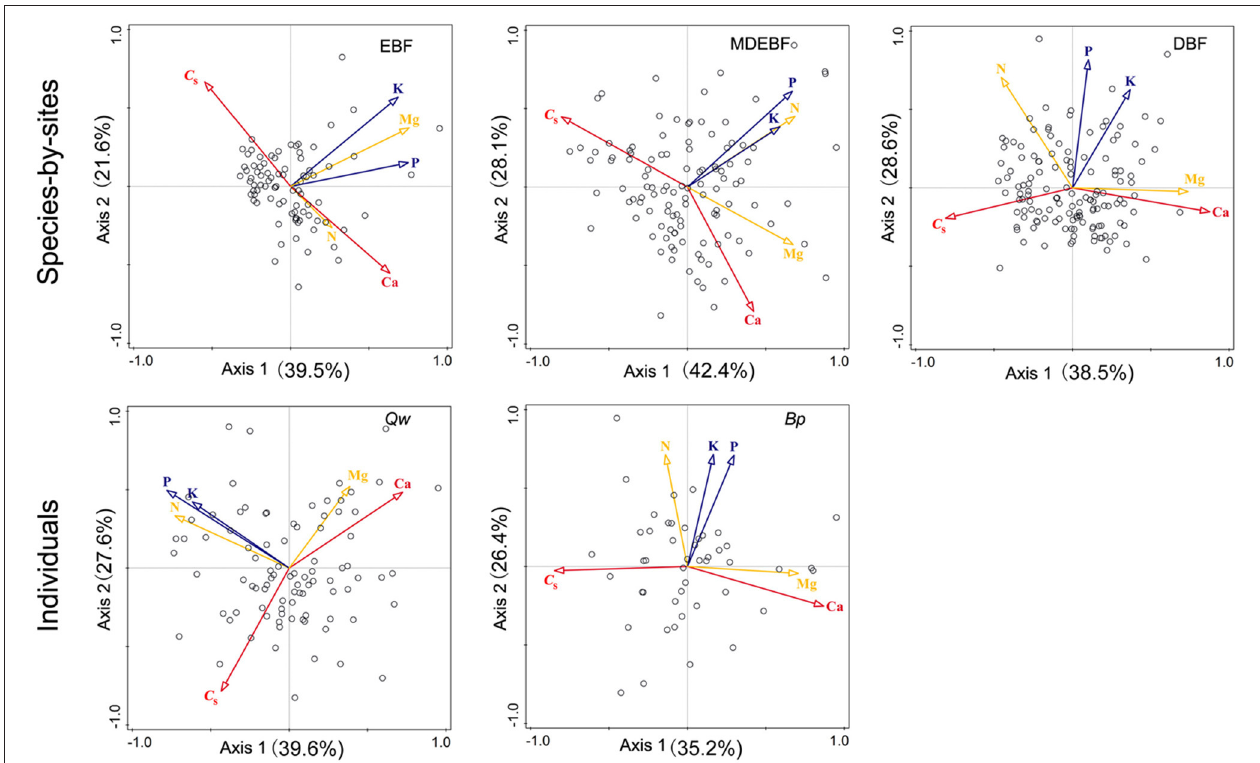
FIGURE 4 | Principal component analyses (PCAs) of leaf protein-free carbon (C S ) and macronutrient concentrations for individuals of Quercus wutaishanica, Betula platyphylla, and species by sites from EBF, MDEBF, and DBF. Abbreviations of sample groups and explanation of trait arrows are described in Figure 1 .